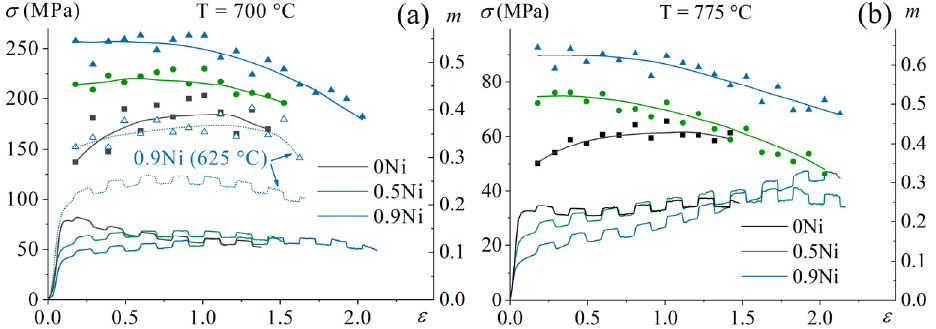
Figure 8. Stress–strain curves and coefficient m dependence of true strain during the step tests according to ASTM standard at ( a ) 700 ° C and ( b ) 775 ° C at the nominal strain rate of 1 × 10 − 3 s − 1 .